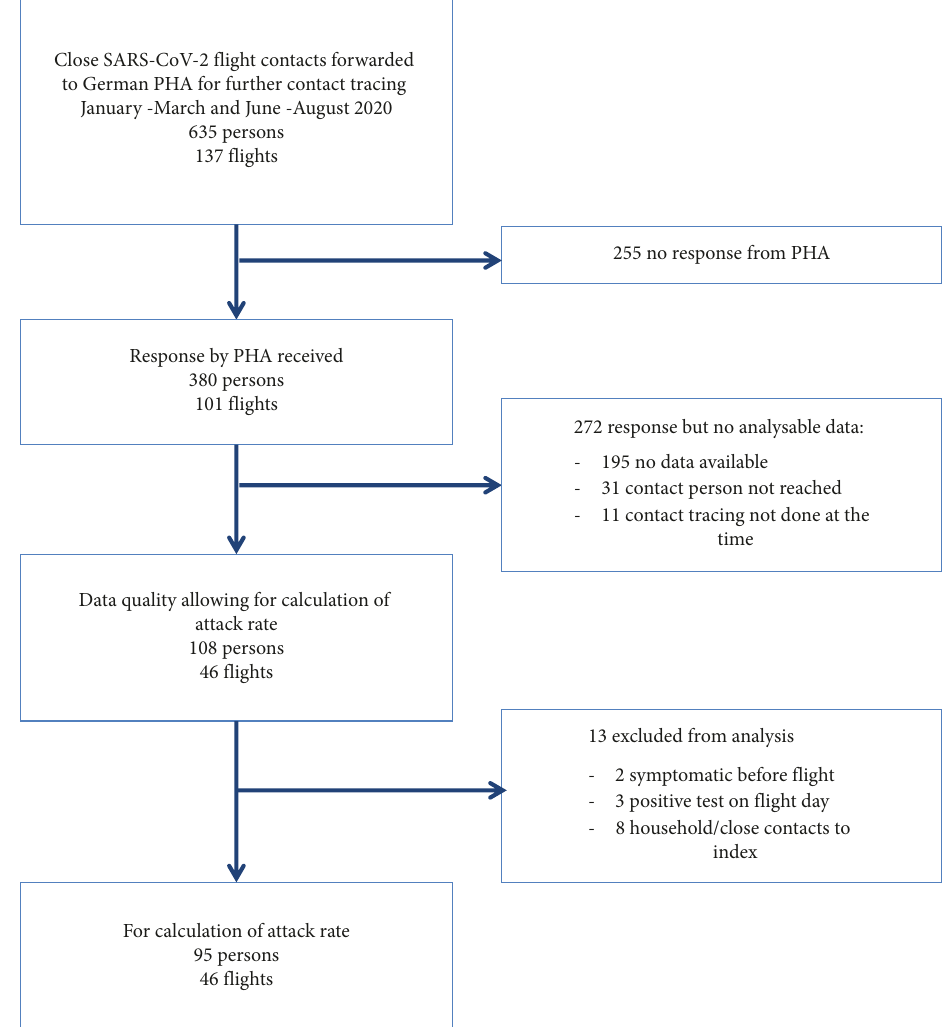
Figure 1: Flowchart for contact persons from follow-up with the PHA until inclusion in the calculation of attack rates, COVID-19 flight contact tracing study, Germany,